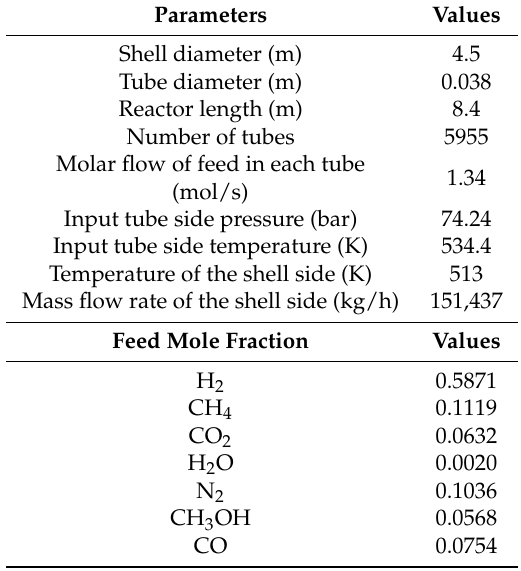
Table 5. The operating conditions and specification of the water-cooled reactor of ACW